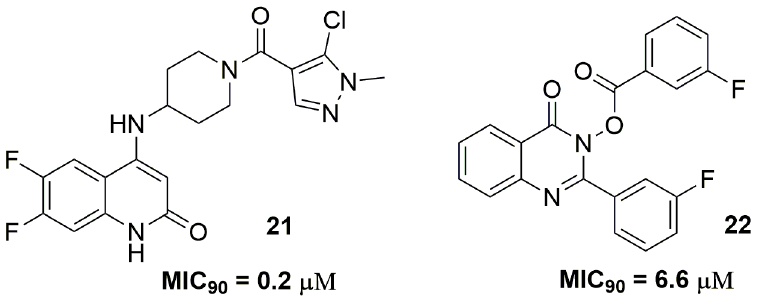
Figure 8. Compounds with antituberculosis activity.